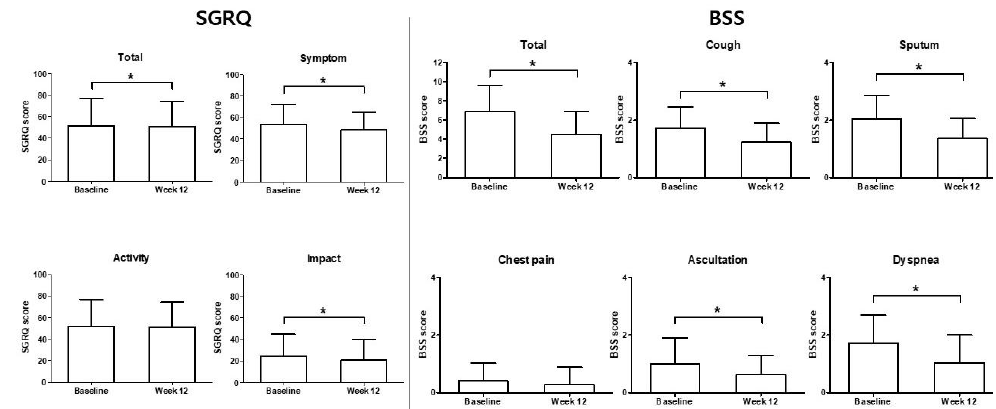
Figure 5. Change of SGRQ and BSS in patients who had concomitant treatment with bronchodilator p -value < 0.0001 (Cf. ‘’Chest pain” p -value: 0.0514) Wilcoxon’s signed-rank test. *: Statistically significant difference